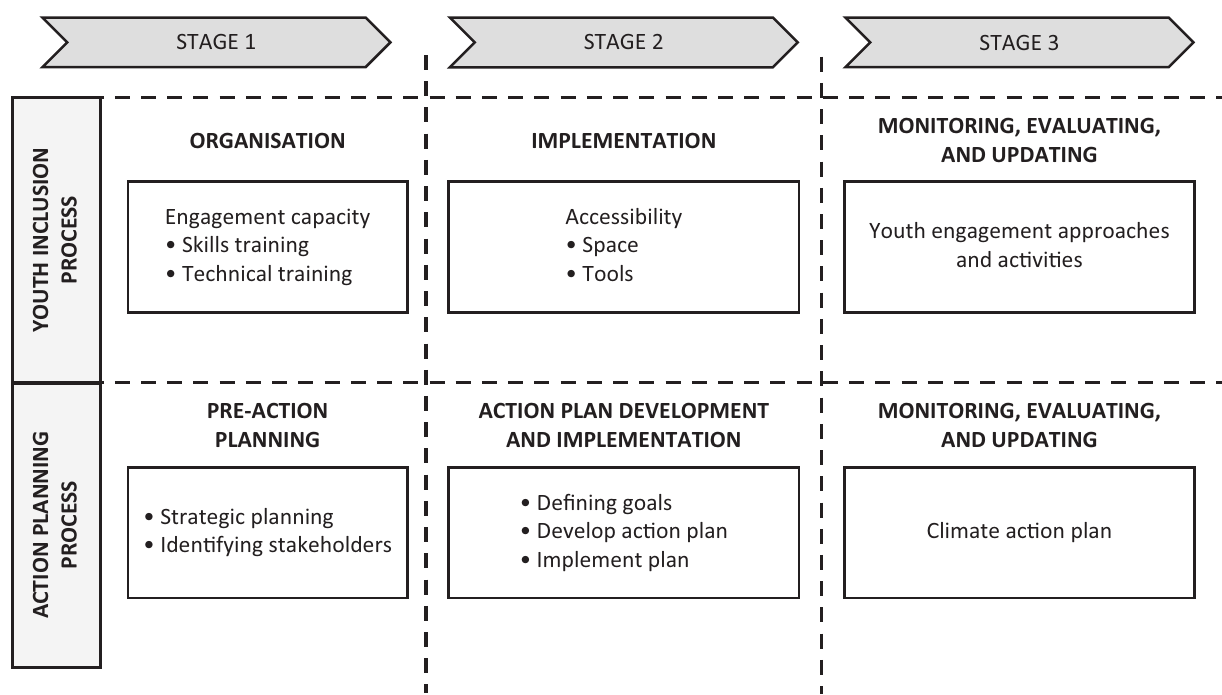
Figure 3. Framework for designing and implementing youth‐inclusive stakeholder engagement